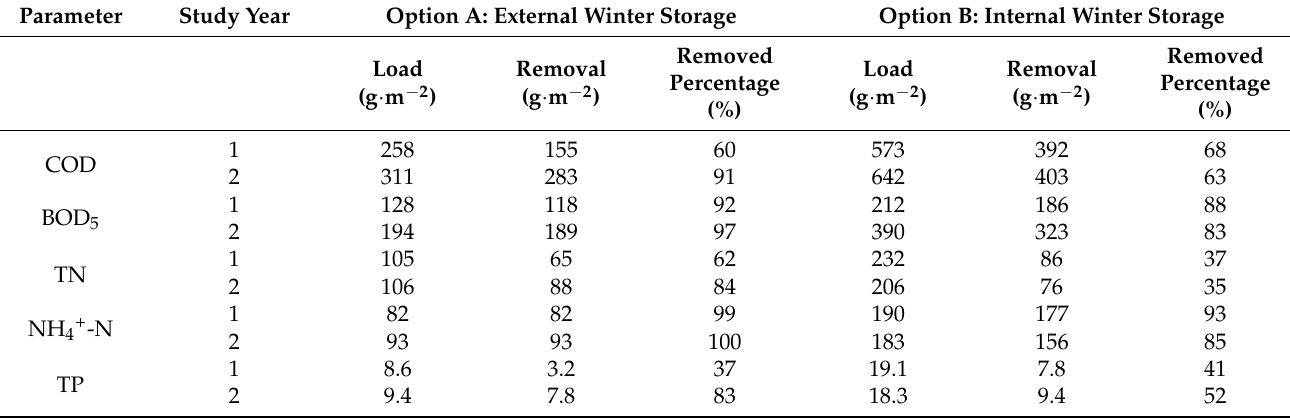
Table 2. Cumulative mass loading and removal rate of the contaminants recorded during both the study years within the